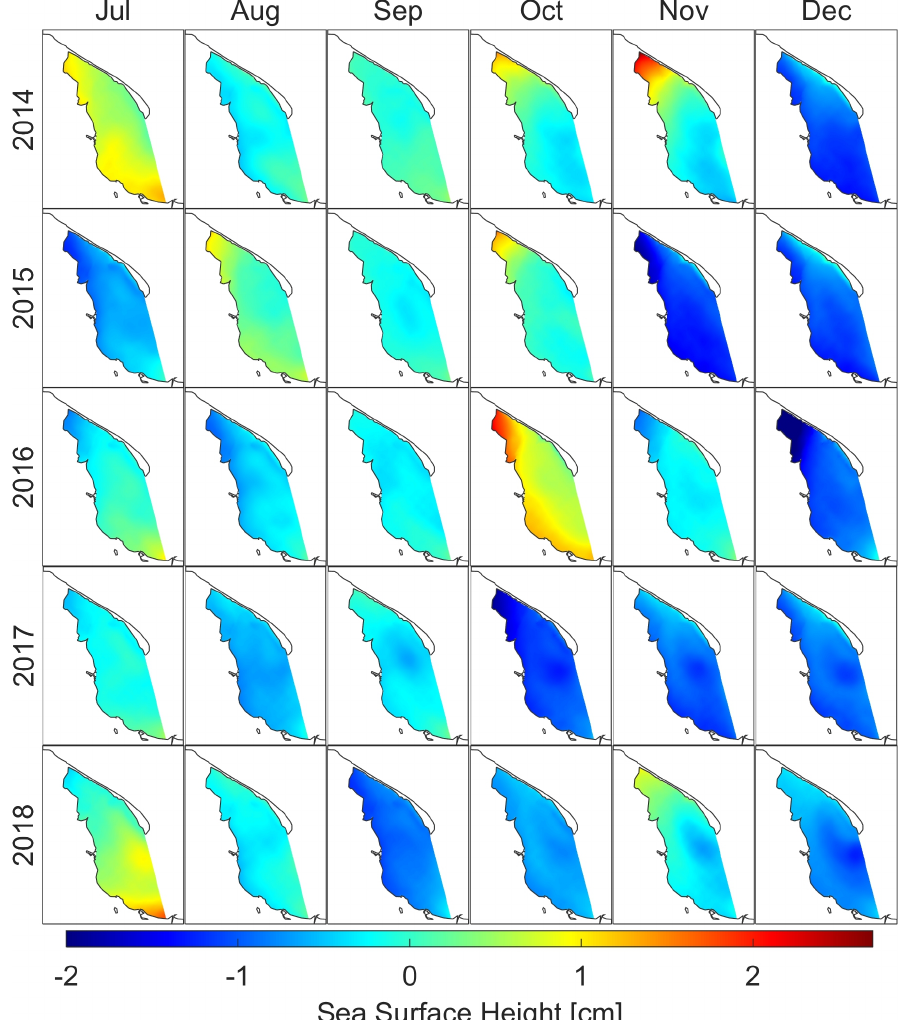
Figure A20. Monthly means of sea surface height for separated years. July to December.